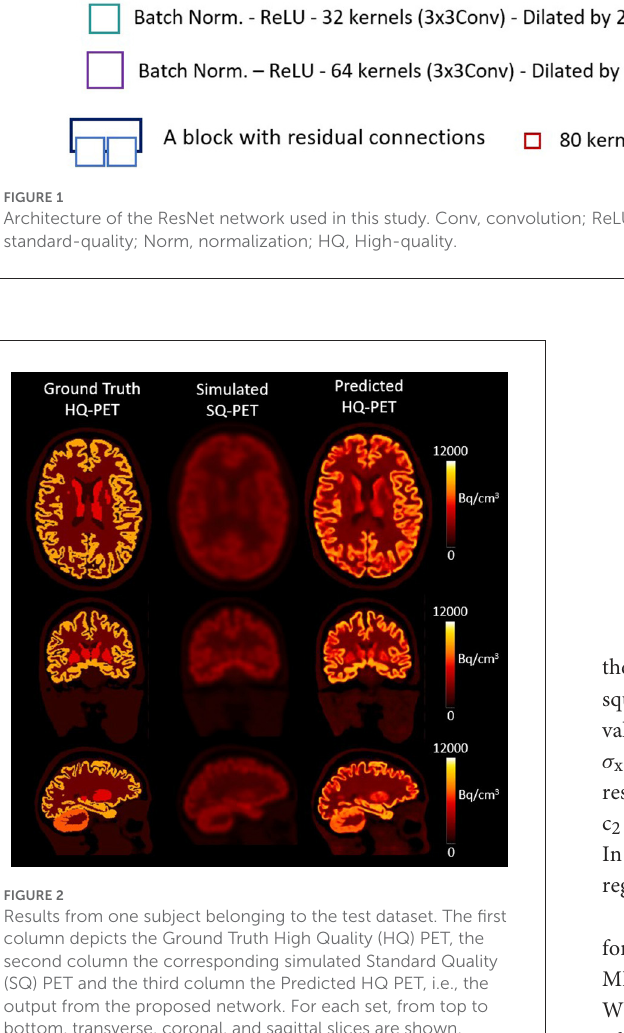
image quality s , and (3) the root mean squared error (RMSE) (Equations 1–3, respectively). An objective improvement in image quality is reflected by larger values in peak signal to noise ratio (PSNR) and structural similarity index metrics (SSIM) and smaller values for the root mean square error